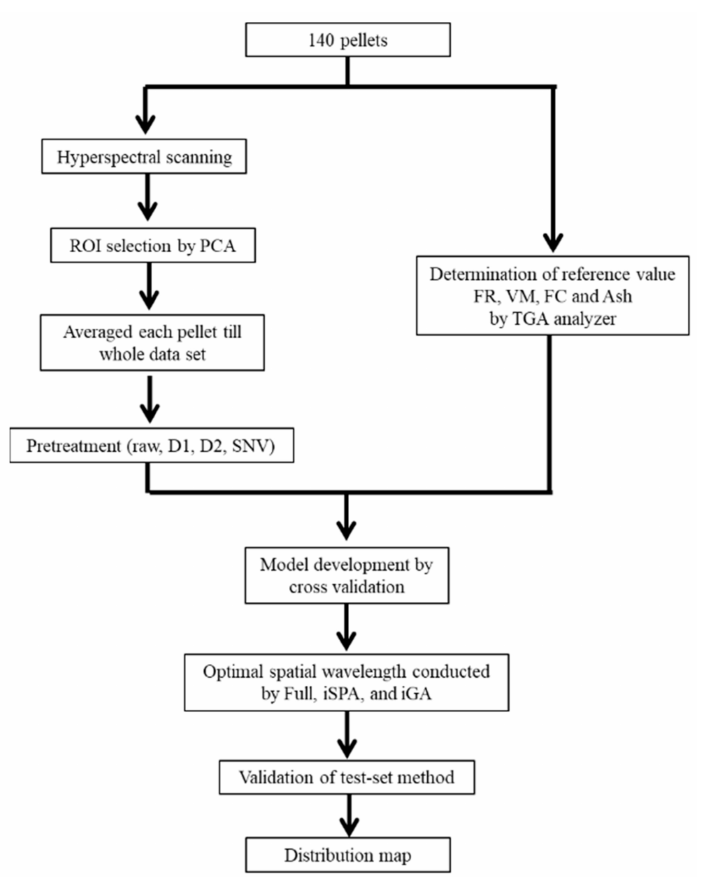
Figure 3. Flow diagrams for prediction of fuel ratio (FR), volatile matter (VM), fixed carbon (FC), and ash (A) by hyperspectral imaging. ROI: region of